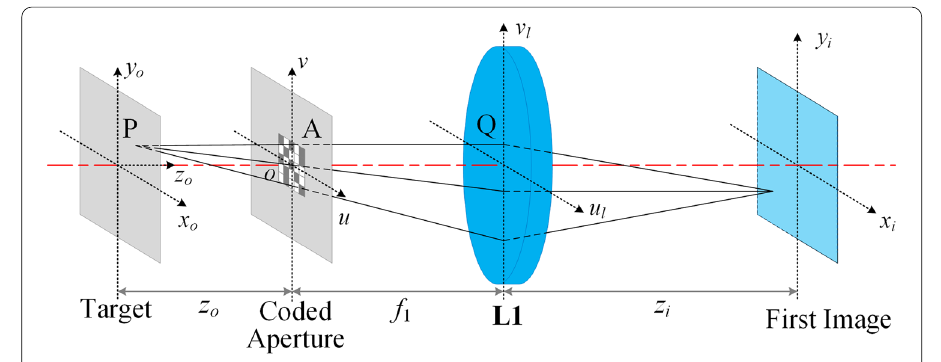
Fig. 2 The layout of Fore Optics